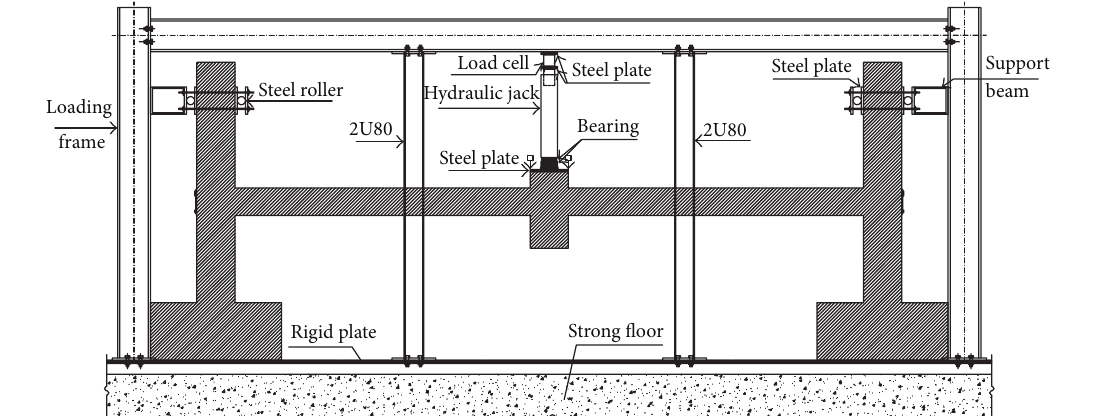
Figure 5: Setup of the test